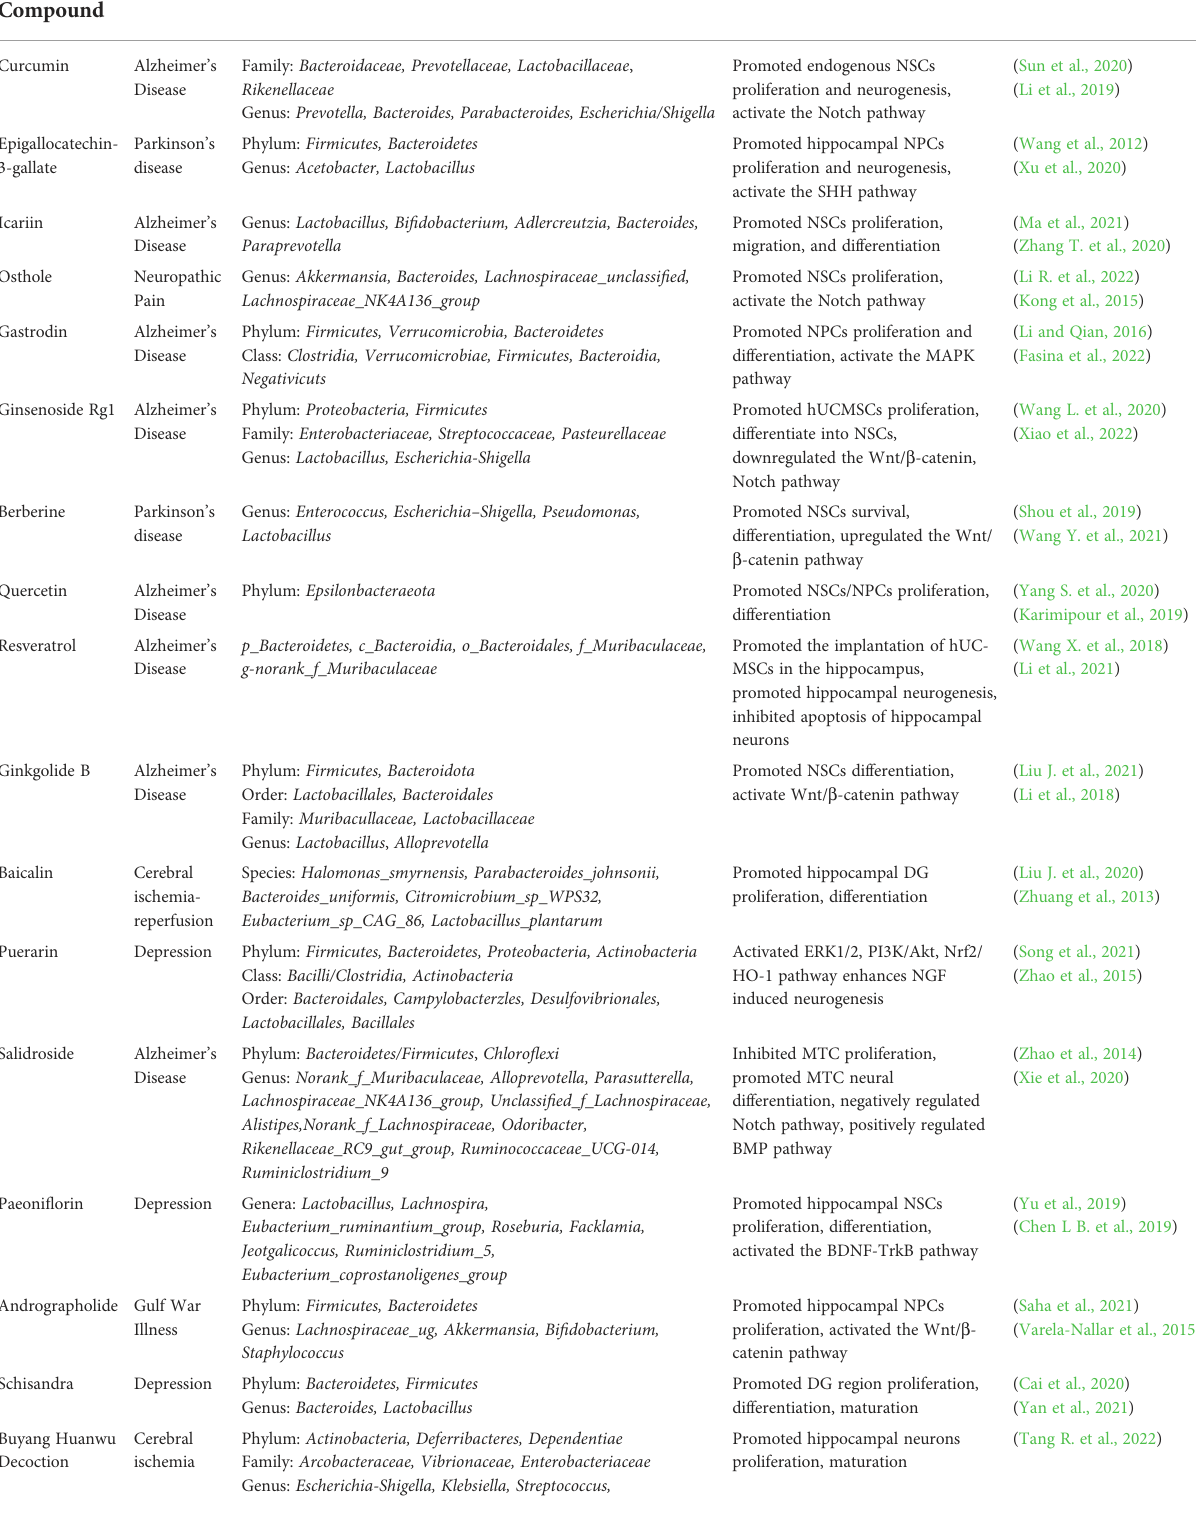
TABLE 3 Effects of Traditional Chinese Medicine and Compound on Gut Micro fl ora and Neurogenesis. Herbal